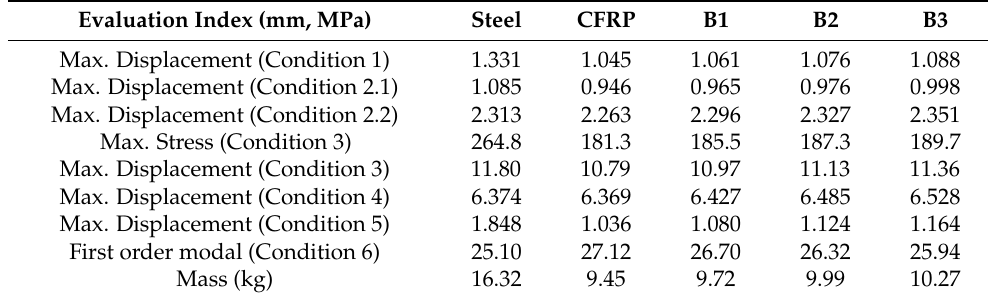
Table 3. Comparison of different hybrid engine hood.